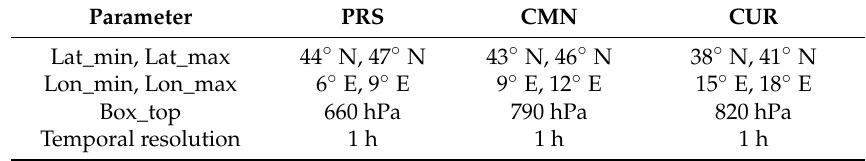
Table 1. Input parameters for STEFLUX in comparison with in situ measurements at the different sites.